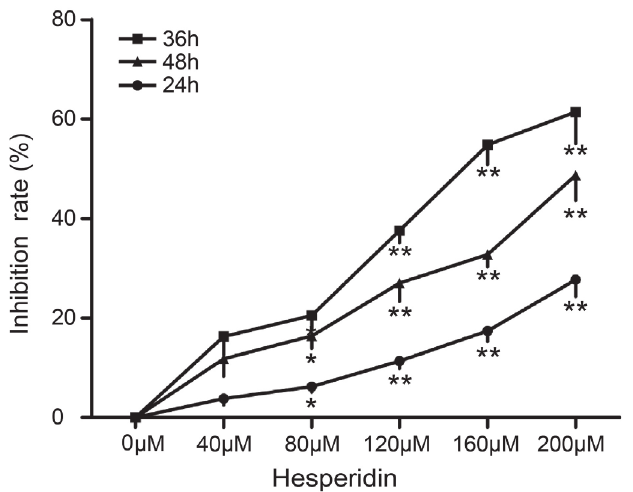
FIGURE 1 - Inhibition of hesperidin in A549 cell